Question: From the figure, is the trend upward or downward?
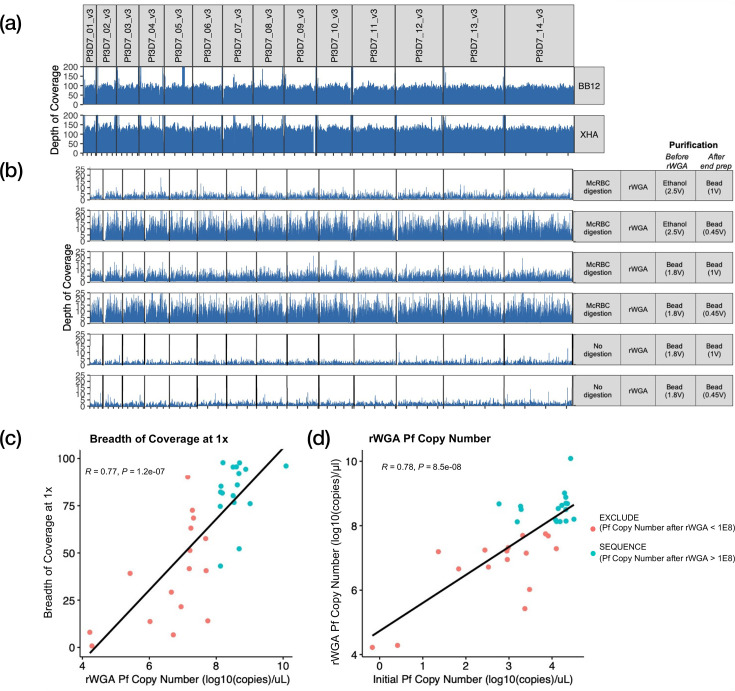
Answer: increasing